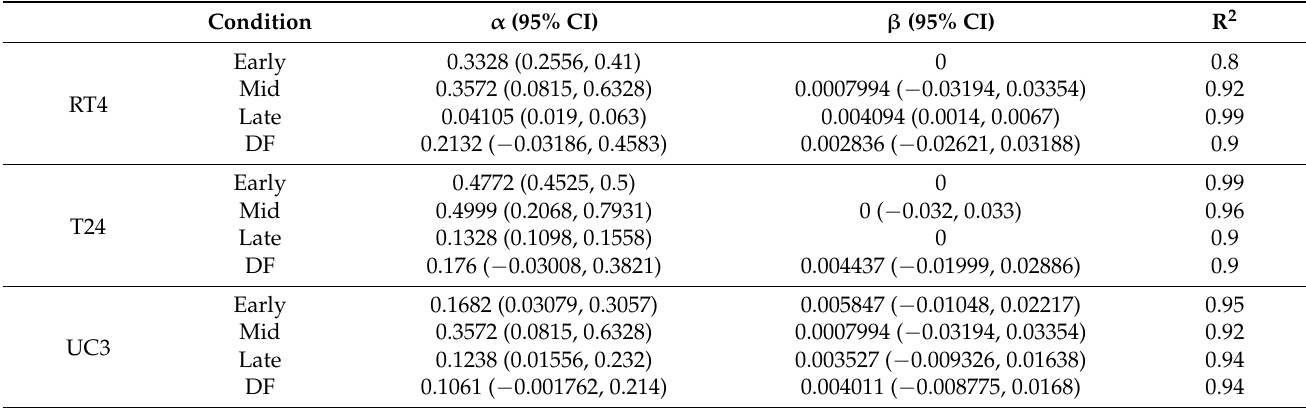
Table 3. Fitting parameters of SR(D). Data were fitted to the LQ model for single (SR ( D )